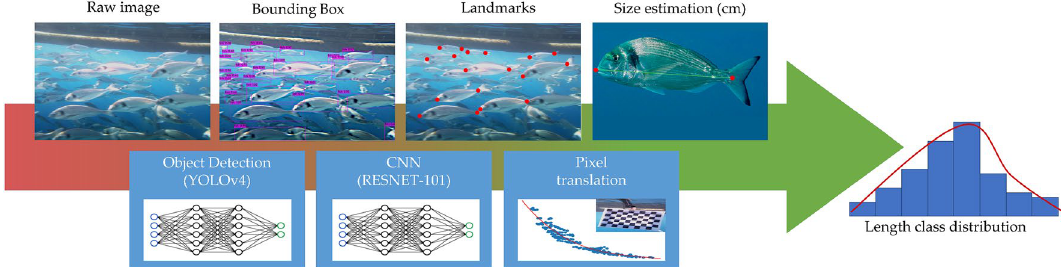
Figure 6. The overall process of the proposed method: automatic AI fish recognition and size